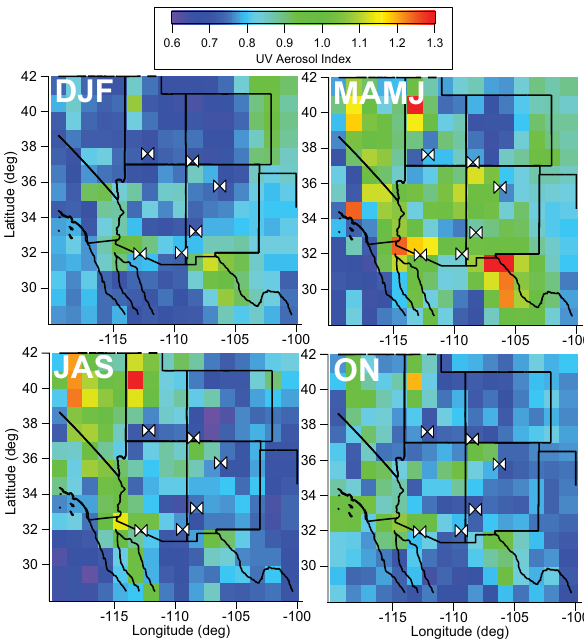
Fig. 4. Average remotely sensed ultraviolet aerosol index values (OMI) in the Southwest between 2005–2008 for four seasons. The white markers correspond to the six co-located pairs of IMPROVE and NADP/NTN